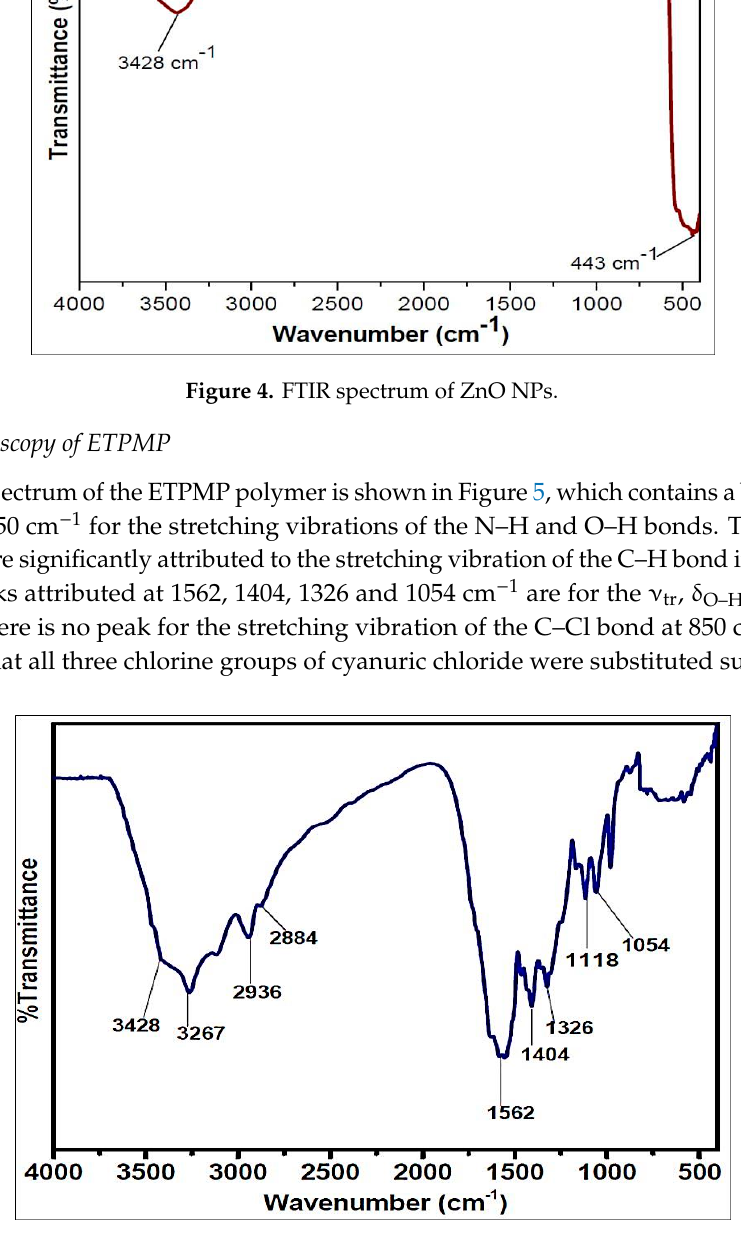
Figure 5. FTIR spectrum of the CFA.